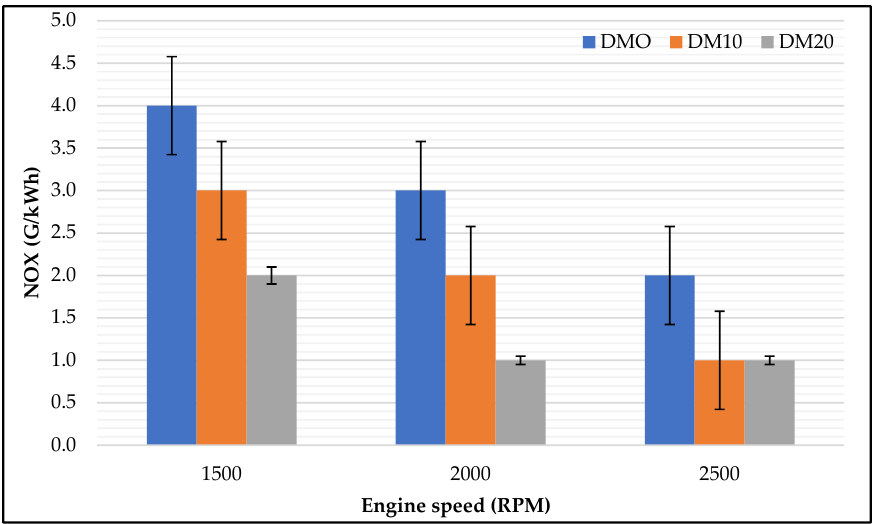
Figure 2. NOx emissions at different engine speeds.